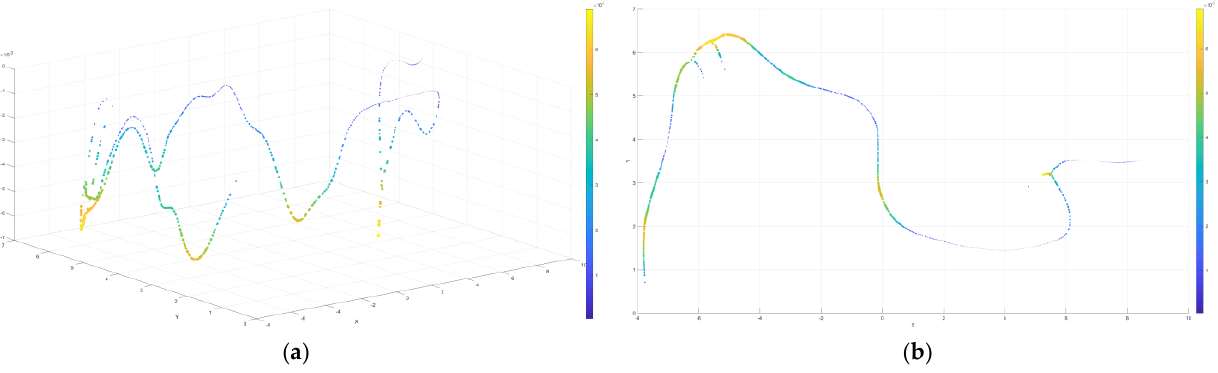
Figure 11. Only forward or backward points exist. We assume an extreme case wherein the pest repeatedly performs a backwards – forwards action on the trajectory of an existing sample point, i.e., all sample points have updated attribute values. ( a ) shows the updated 3D view; ( b ) shows the up- dated x − y plane view. The updated worm path range changes from ( – 4, 5) to ( – 8, 10) for x, from (0, 3.5) to (0, 7) for y, and from (0.5 × 10 −3 , 5 × 10 −3 ) to (1 × 10 −3 , 6 × 10 −3 ) for |z|. It can be seen that the backward and forward movements have a large effect on the x and y values, while the z values change relatively